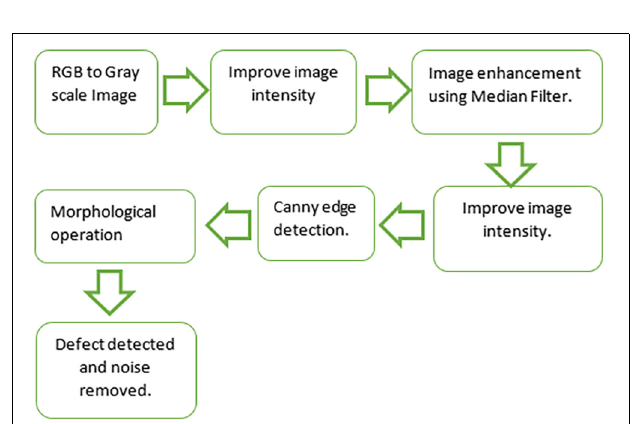
FIGURE 7 | Image processing flow